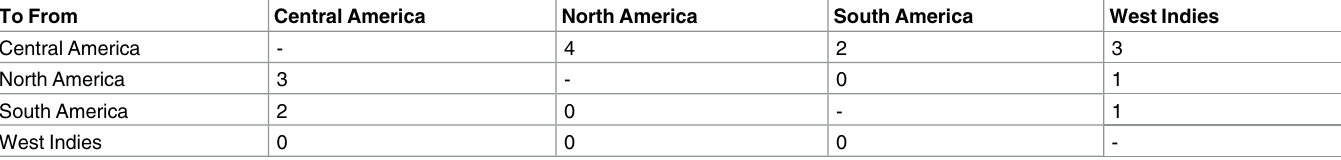
Table 4. Dispersalevents in Poeciliinae based on MAC parsimony and DEC + J * . To